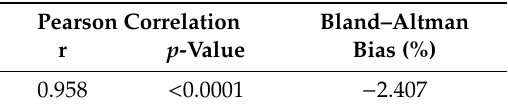
Table 2. Comparison between the concentration values given by manual analysis, and by the Sperm Concentration Module included in OpenCASA. Both methods were compared using the Pearson correlation test and the Bland–Altman